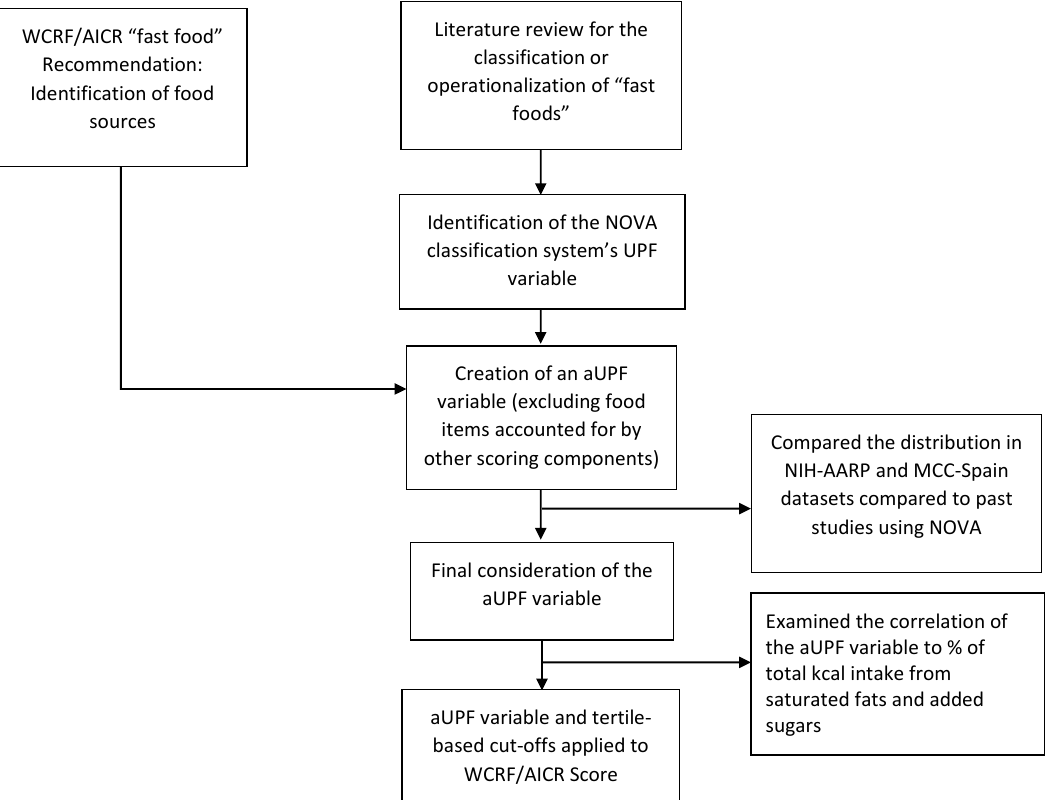
Figure 1. Flow chart: the creation of the adapted ultra-processed foods variable to represent “fast foods”. aUPF, adapted ultra-processed food; AICR, American Institute for Cancer Research; MCC-Spain, Multi-Case Control (MCC-Spain) study; NIH-AARP, National Institutes of Health-AARP (formerly known as the American Association of Retired Persons); UPF, ultra-processed food; WCRF, World Cancer Research Fund.